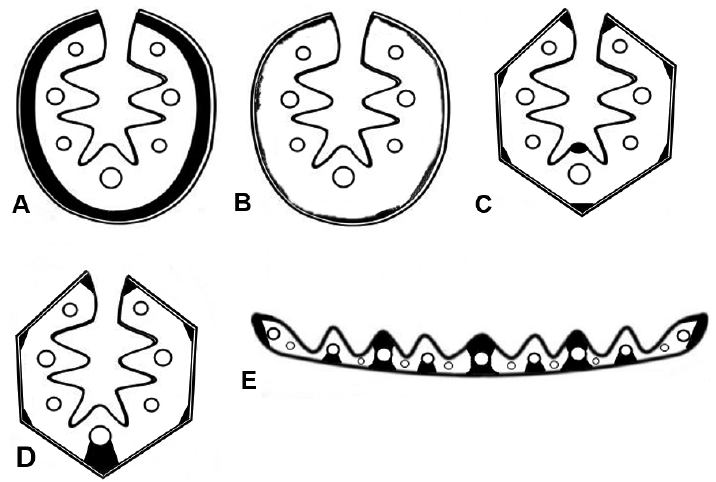
Figure 2. Major types of arrangement of sclerenchyma found in the leaf cross-sections. In conduplicate leaf blades: A continuous ring B interrupted continuous ring C forming abaxial strands and an adaxial strand on the median rib D with an abaxial girder at the median vascular bundle. In flat leaf blades: E complete (abaxial and adaxial) girder at the first vascular bundles, abaxial girder at the second vascular bundles, third vascular bundles without associated sclerenchyma.